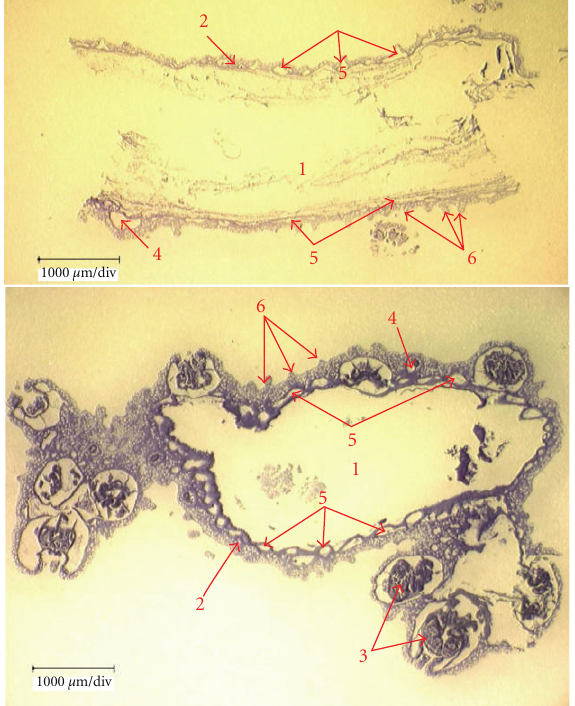
Figure 4: Histological sections of Paracorallium japonicum ; longi- tudinal section in base part of OCA-Cn20080329-020 (above), and transverse section in branch tip of OCA-Cn20060212-033 (below). 1: axis, 2: coenenchyme, 3: autozooid, 4: siphonozooid, 5: vasucular canals, 6: wart.